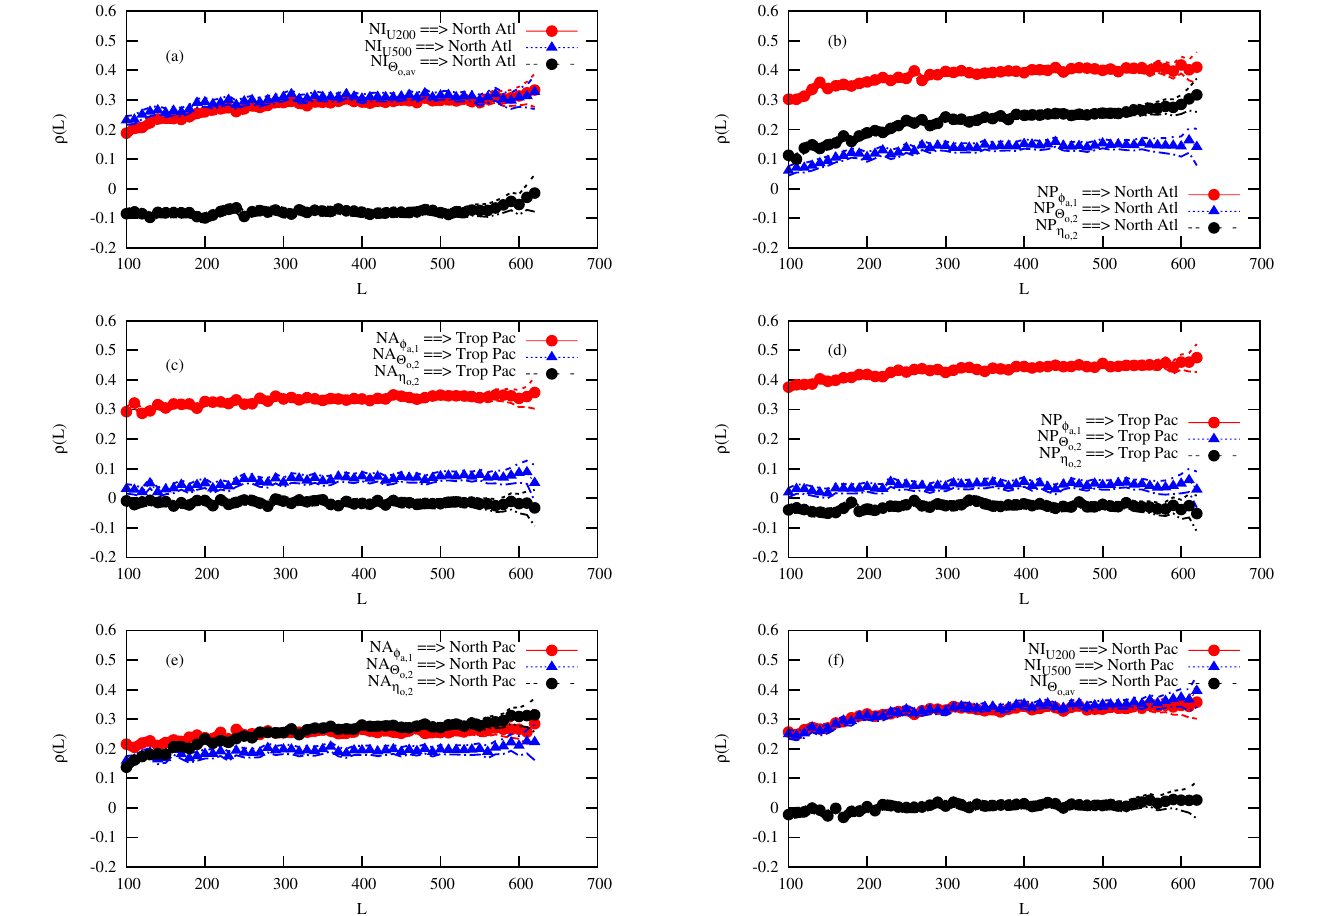
Figure 3. CCM as a function of the length L of the samples, as obtained from the monthly time series displayed in Fig. 1 for the ERA-20C and ORA-20C reanalyses. Each line with symbols corresponds to the influence of one variable on a specific coupled ocean–atmosphere basin. The specific variables are denoted in the caption corresponding to each line in each